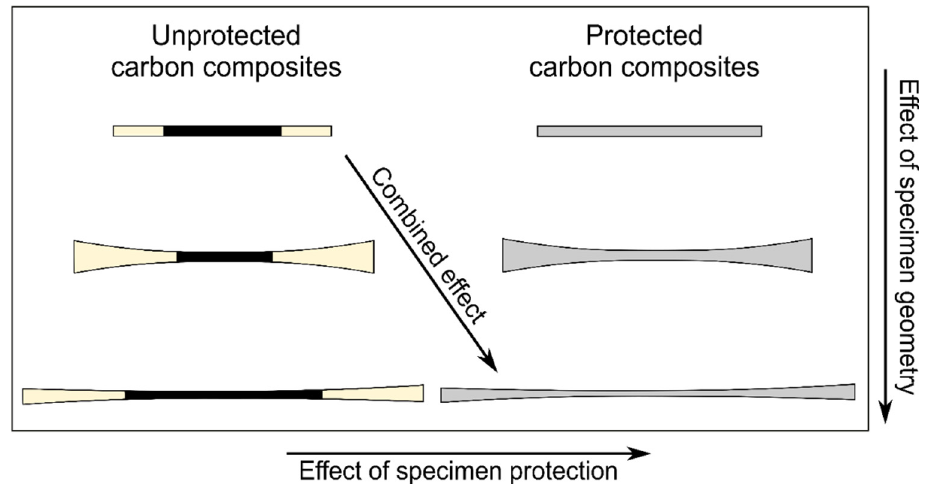
Figure 3. Schematic diagram representing the design of the experiments.